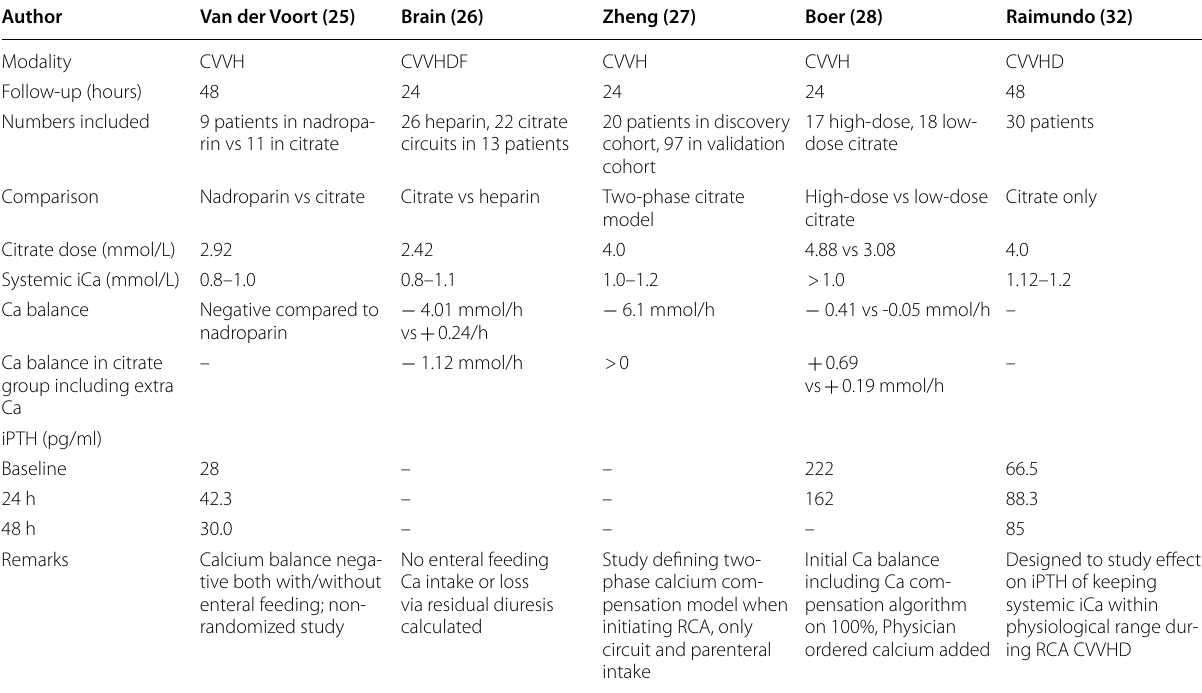
CVVH continuous veno-venous hemofiltration, CVVHDF continuous veno-venous hemodiafiltration, CVVHD continuous veno-venous hemodialysis, iPTH intact parathyroid